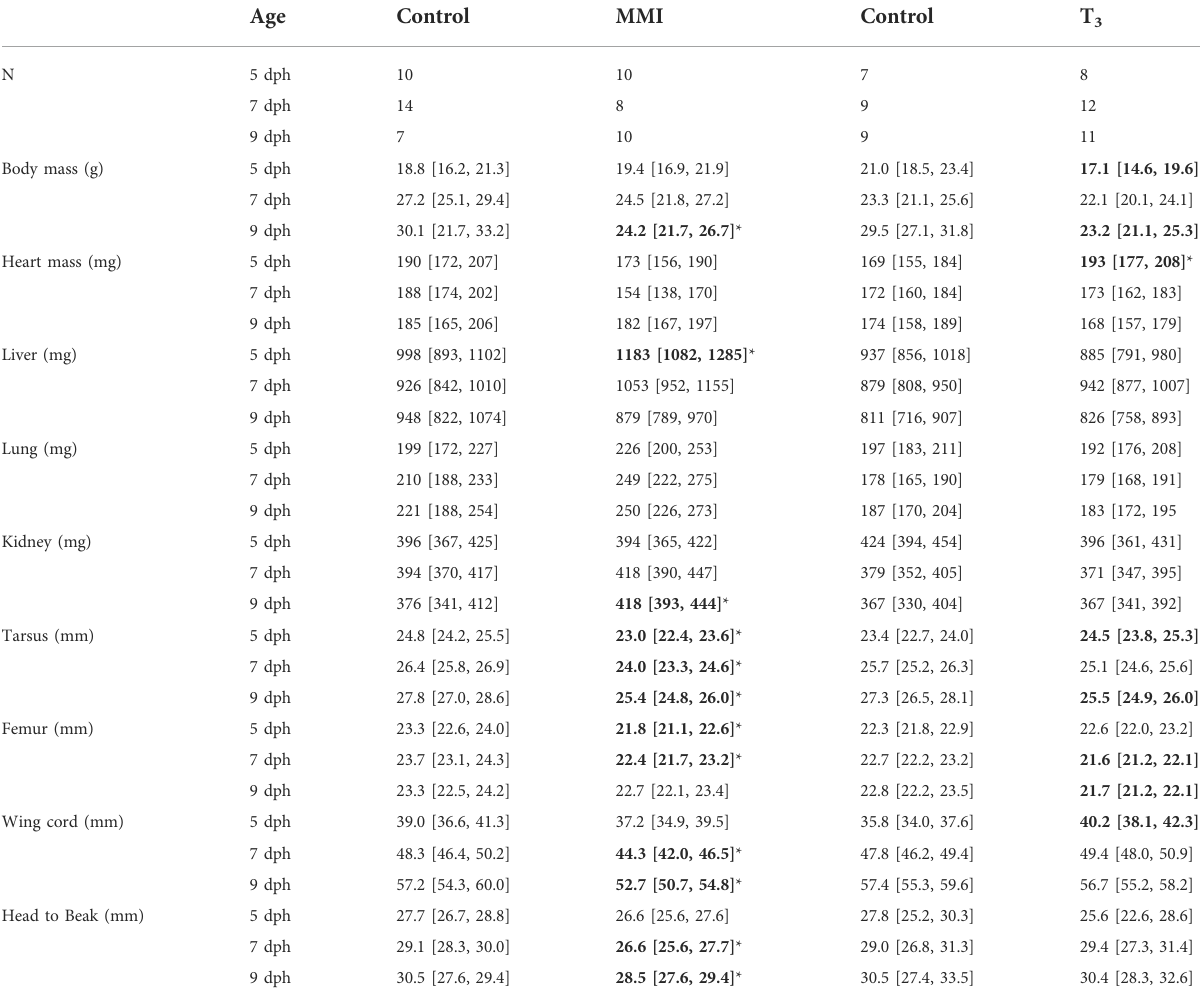
TABLE 1 Nestling red-winged blackbird body masses and ANCOVA estimated marginal means of morphometric measures with body mass as a covariate from MMI treatment experiment and T 3 treatment experiment. Data presented as mean [95% CI]. Values in bold with an asterisks indicate very large effects (Cohen ’ s d > 1.2) of treatment on the parameter in comparison to the